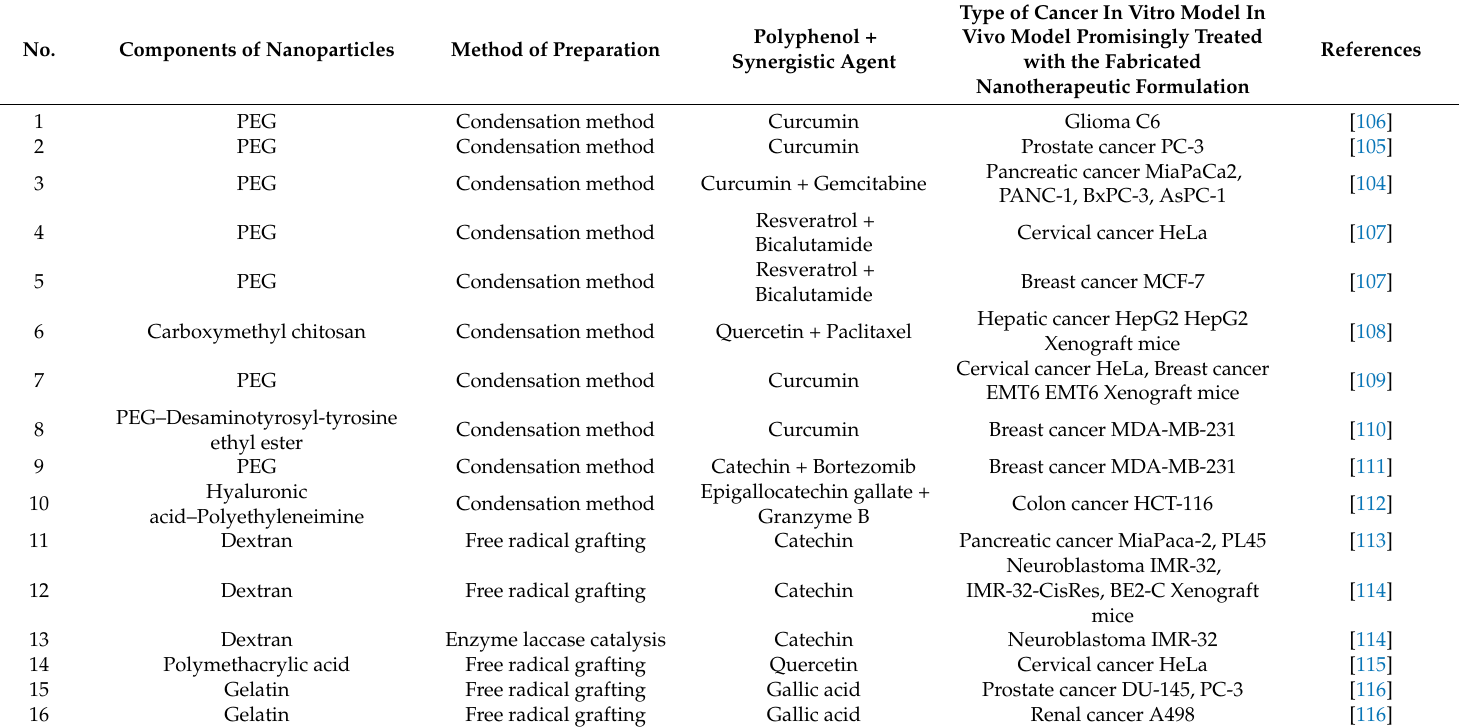
Table 5. Polyphenol-loaded polymeric conjugates for the treatment of